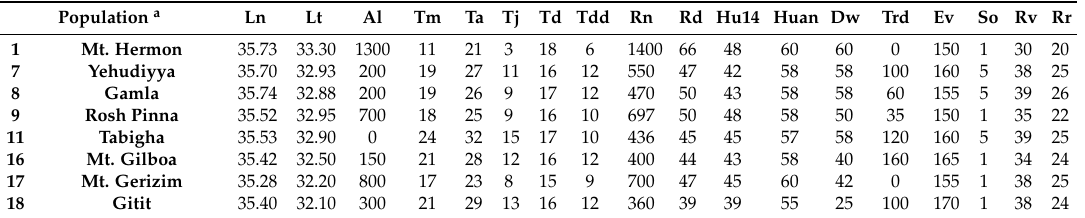
Table 1. Geographical and climatic data for the 15 WEW populations from Israel and Turkey that were used in this